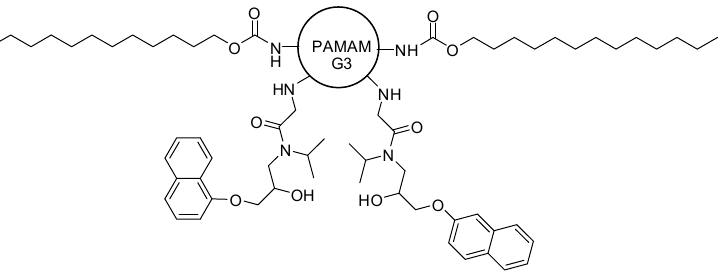
Figure 4. G3 PAMAM dendrimer prodrugs containing propranolol with surface changes [35].